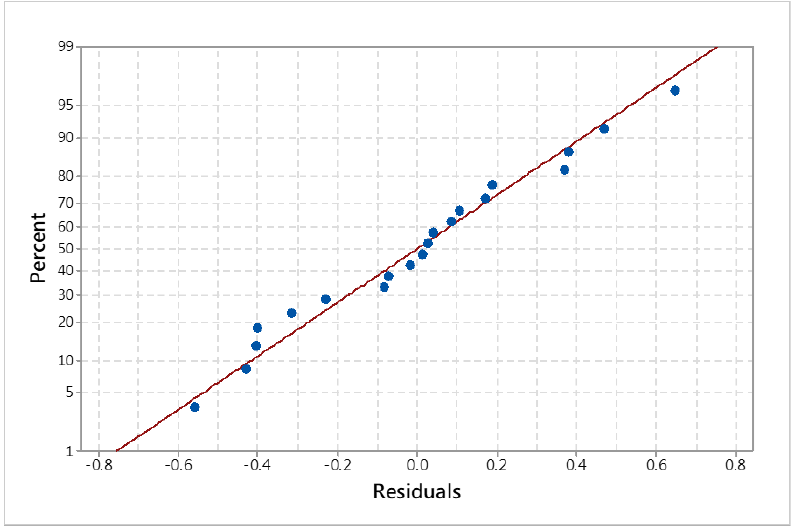
Figure 4. The residual analysis for A1024 and ID area_Shannon in the SQRT_MT model shows a good fit with the straight line. The p −value, 0.772, was higher than the criterion (α = 0.05.) .